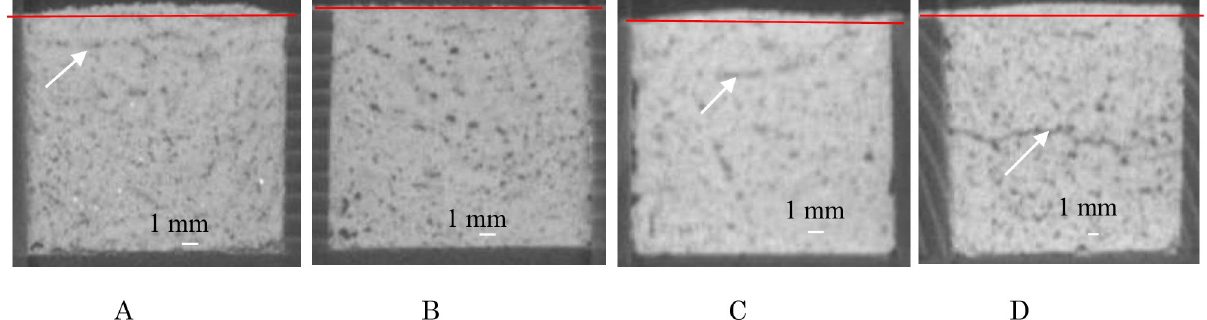
Fig 1. Volume expansion and delamination (cracks: White arrow) of new mortar samples. A Volume expansion of sample A (Nittetsu cement; 6%). B Volume expansion of sample B (extracted Nittetsu cement; 0%). C Volume expansion of sample C (extracted cement including AE water-reducing agent; 9.4%). D. Volume expansion of sample E (Kazakhstan cement including AE water reducing agent; 6.1%).